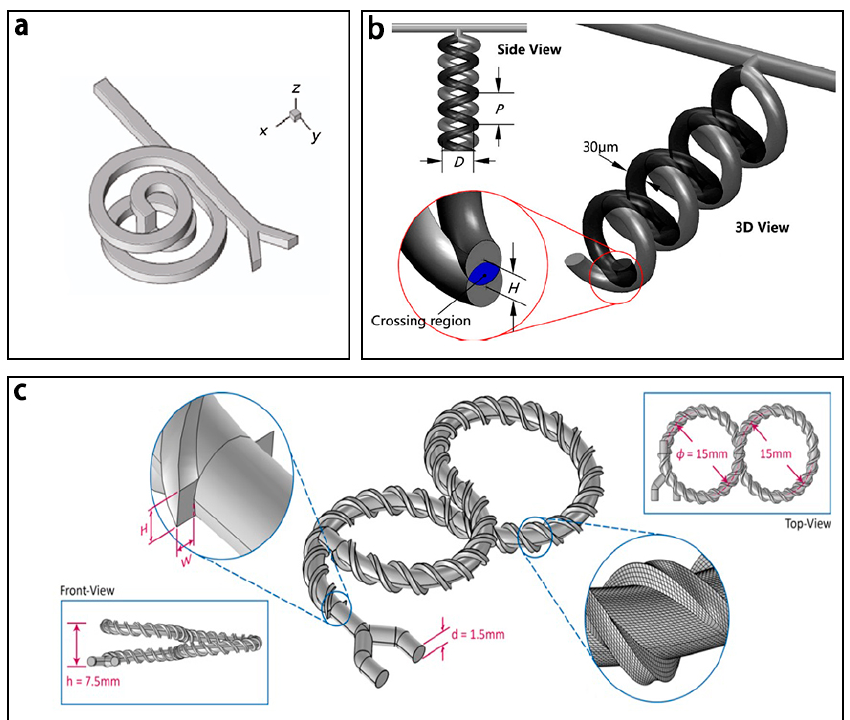
Figure 20. Schematic of the 3D spiral based micromixer ( a ) with two spiral microchannels and an erect channel; ( b ) with double helical channels in opposite directions; and ( c ) with 3D spiral and fine-threaded microchannel. Reproduced with permission from [112,113,148].